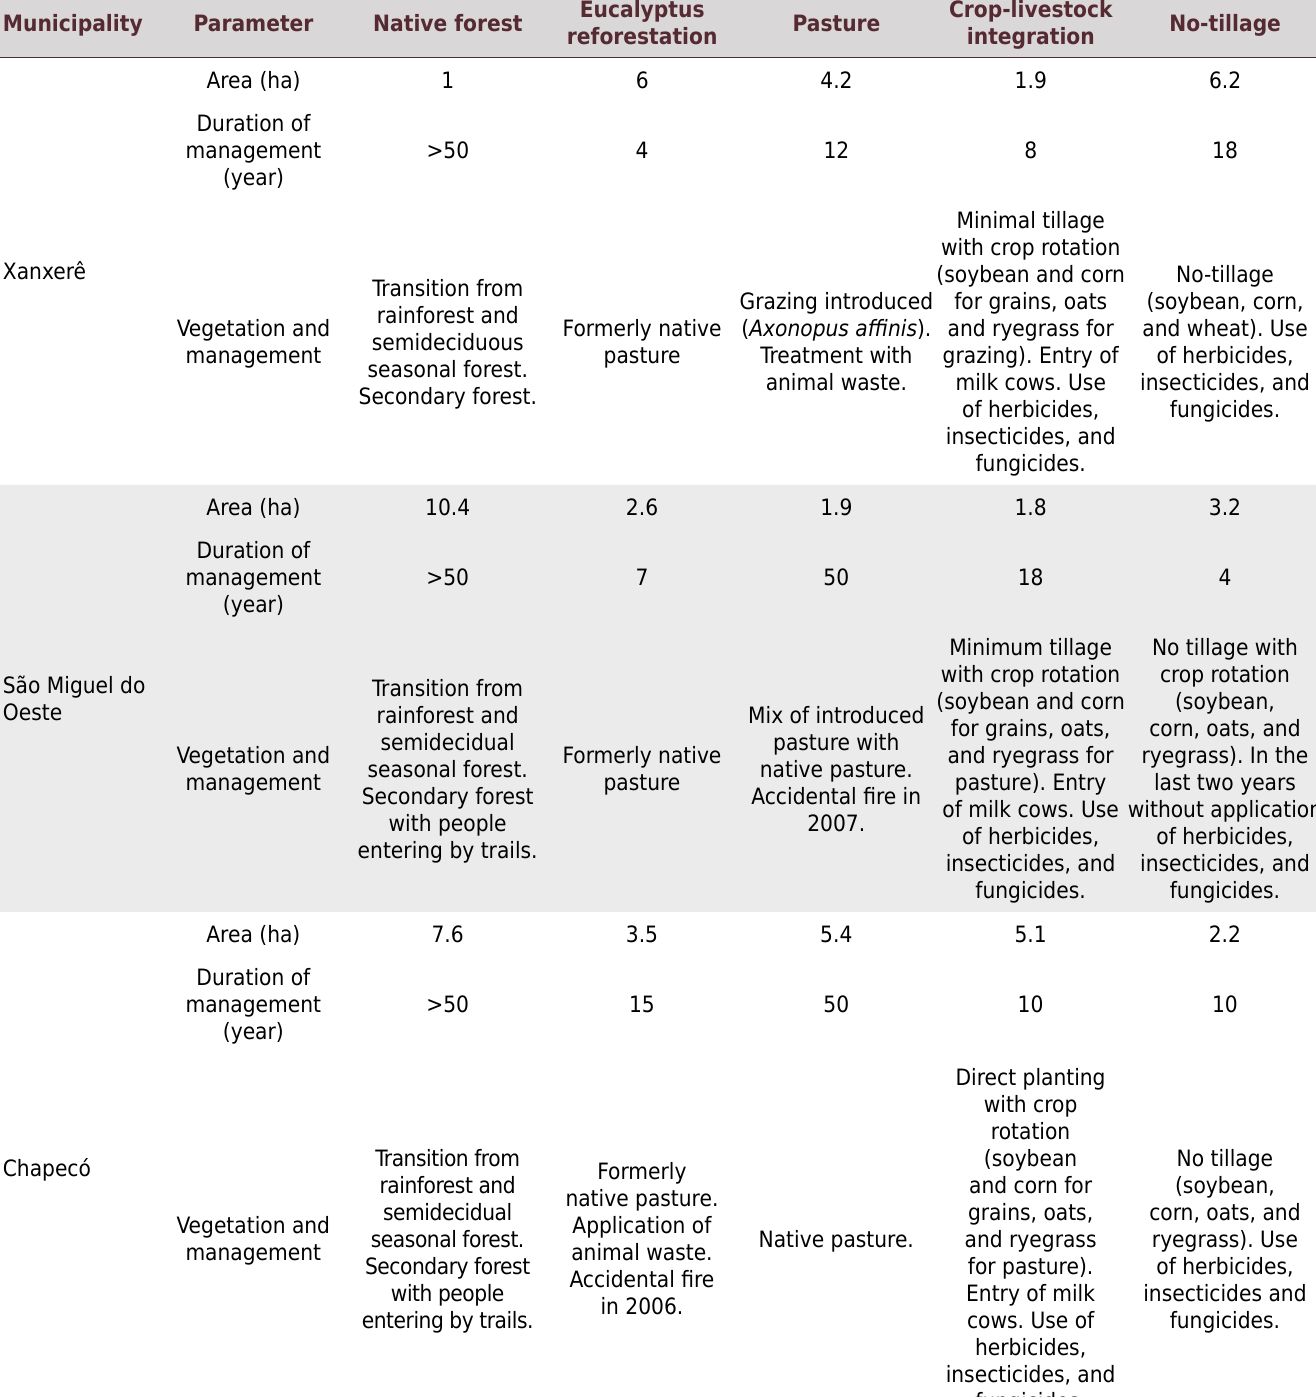
Table 1. History of use of the evaluated areas in the western region of Santa Catarina Municipality Parameter Native